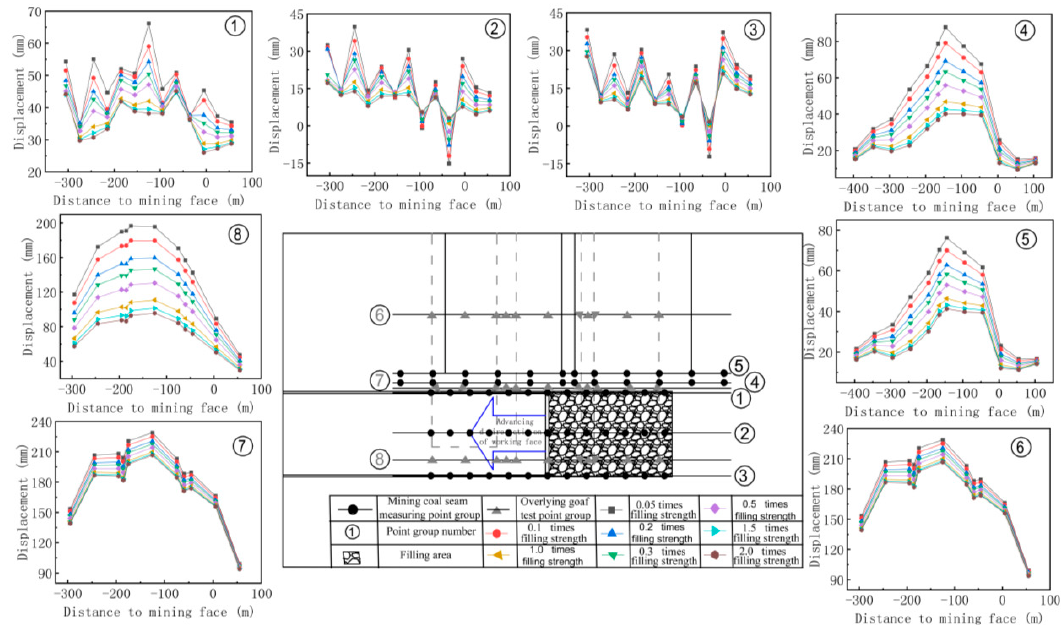
Minerals 2018 , 8 , x FOR PEER REVIEW Figure A3. Movement characteristics of coal and rock strata (300 m). Figure A3. Movement characteristics of coal and rock strata (300 m).